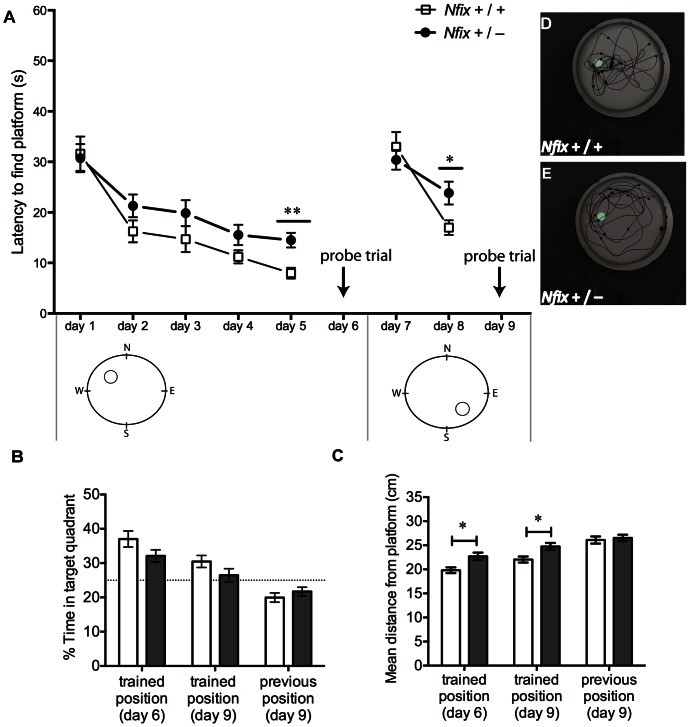

Nfix+/− mice have impaired spatial learning and memory.Training latencies (A) and probe trial performances (B–E) of adult wild-type and Nfix
+/− mice during the Morris water maze task. Over the initial 5 days of hidden-platform training (days 1–5) Nfix
+/− mice took significantly longer, on average, than wild-type mice to find the platform (**p<0.01), taking almost twice as long on training day 5 (**p<0.01; A). During the reversal learning procedure (days 7–8) Nfix
+/− mice took longer to find the platform on training day 8 (*p<0.05; A). The average search path of Nfix
+/− mice was further away from the trained position of platform during the probe trial on day 6 and day 9 (*p<0.05; C). A similar trend was observed for time spent in target quadrant (B). A representative performance of a wild-type mouse and a Nfix
+/− mouse during the probe trial on day 6 is pictured in (D) and (E) respectively. (Nfix
+/+: n = 20, Nfix
+/−: n = 26).